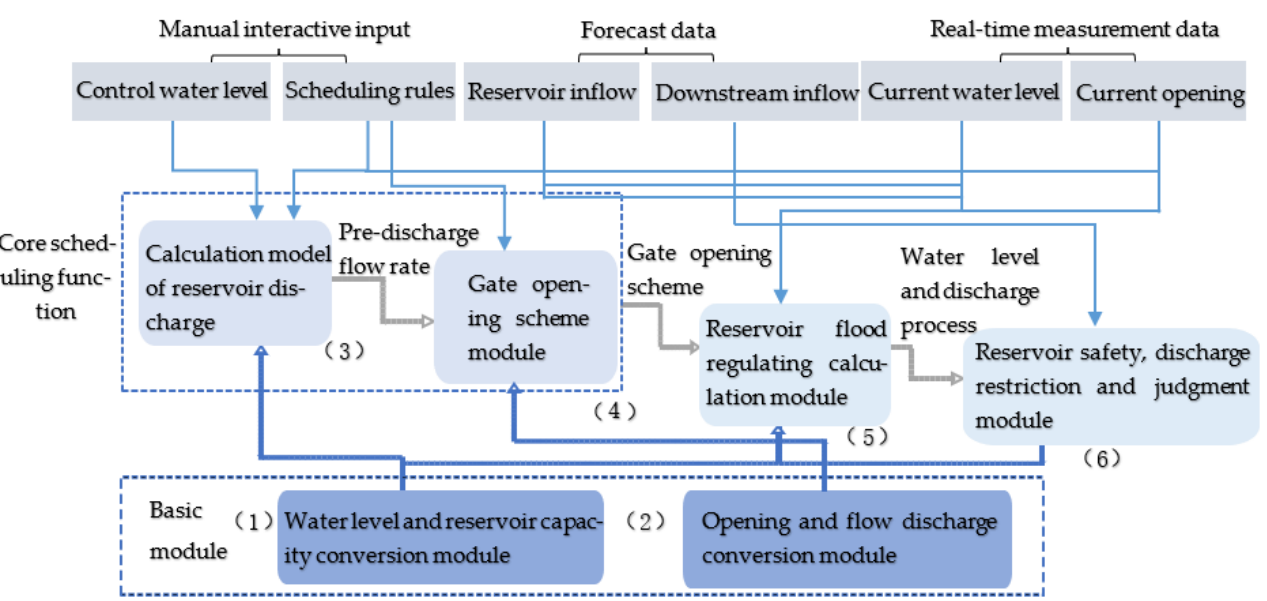
Figure 4. Dividing the design of the plug-in module for the reservoir basic flood control schedul- ing